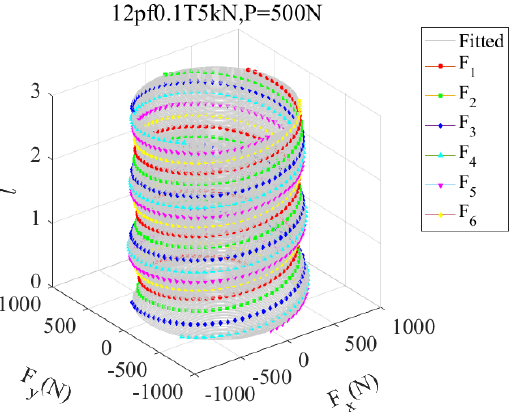
Figure 20. The fitting results of the force cycle [ R i , r i , ϕ i ] to force group [ F wi , θ wi ] made up of tension force and associated angular position of each wire on the cross-section along the longitudinal axis for the 12-pitch-long strand in condition where μ = 0.2, T = 5 kN and P = 500 N.